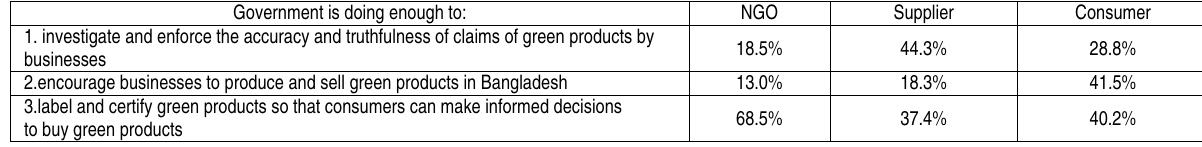
Table 8. Opinion of the stakeholders regarding government support to green product Government is doing enough to: